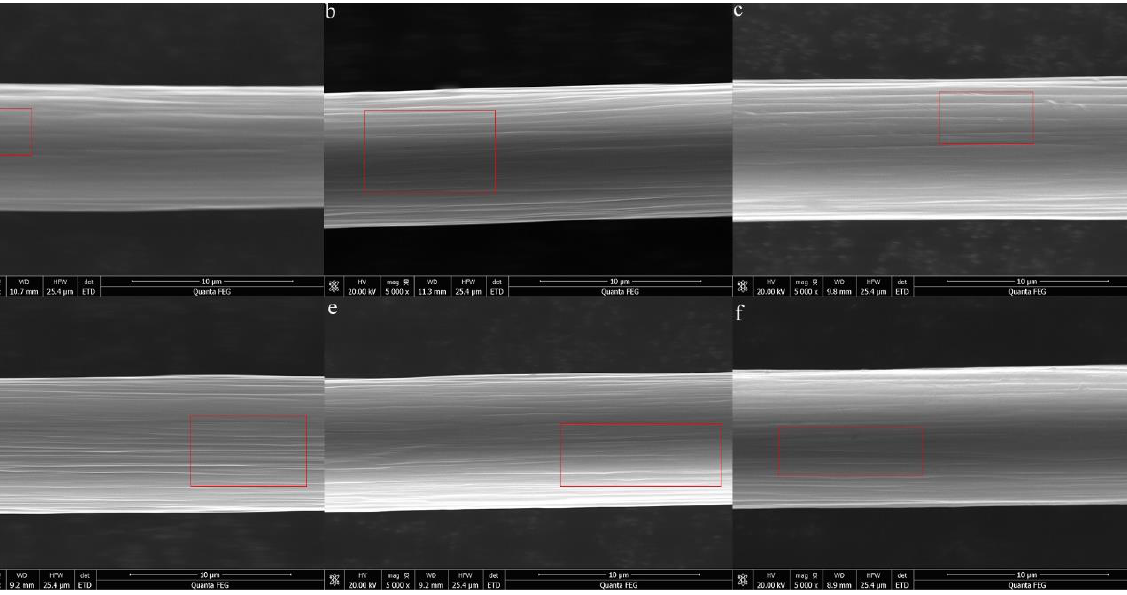
Figure 5. IR spectra of the samples.